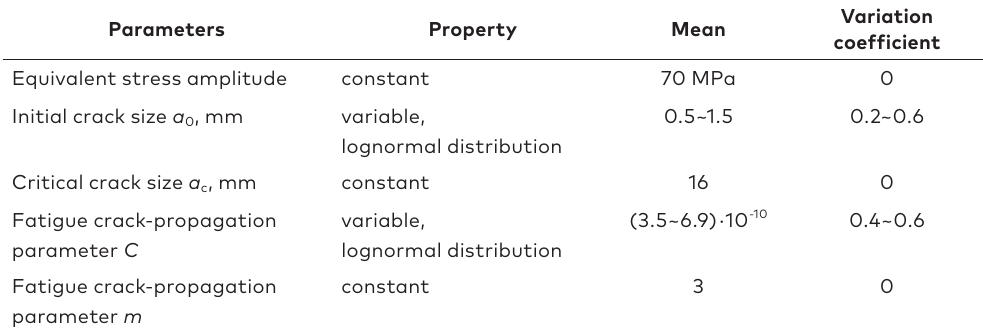
Table 4. Parameters of fatigue reliability